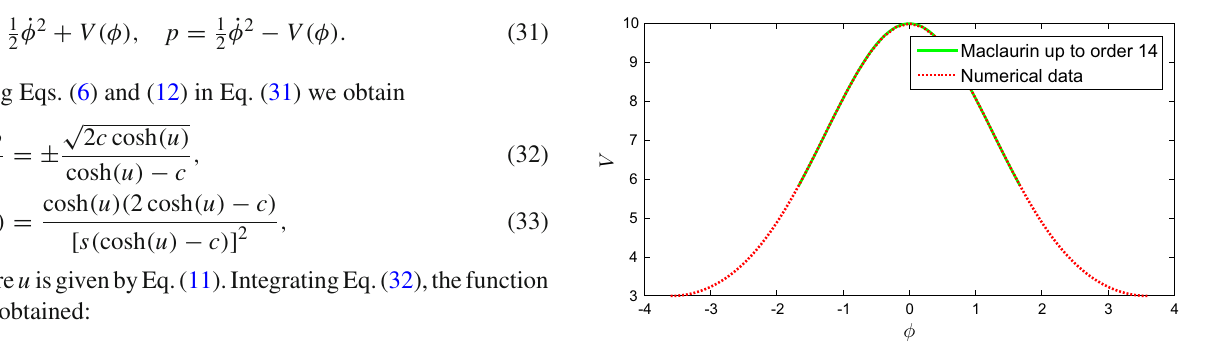
Fig. 5 Plot of V (φ) using the Maclaurin series obtained in Appendix A, Eq. (A21), as well as by the numerical integration from Eq. (33), for the particular parameter values c = 0 . 5 and s =